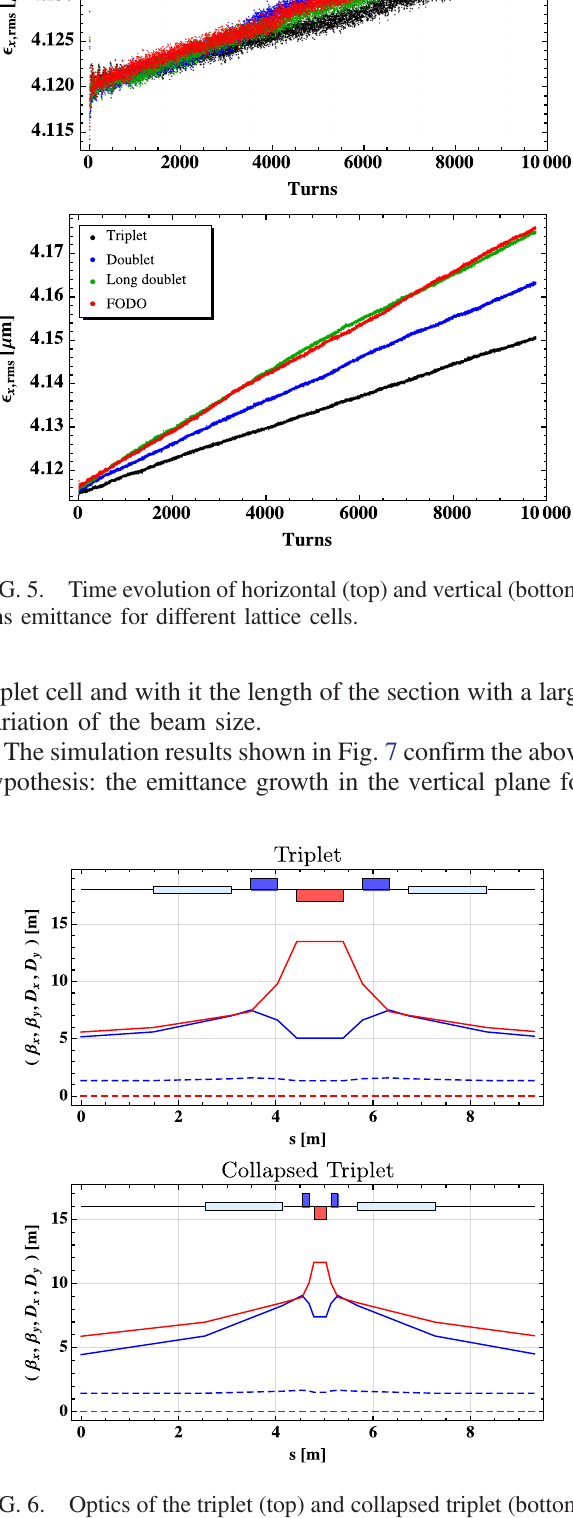
FIG. 6. Optics of the triplet (top) and collapsed triplet (bottom) cell